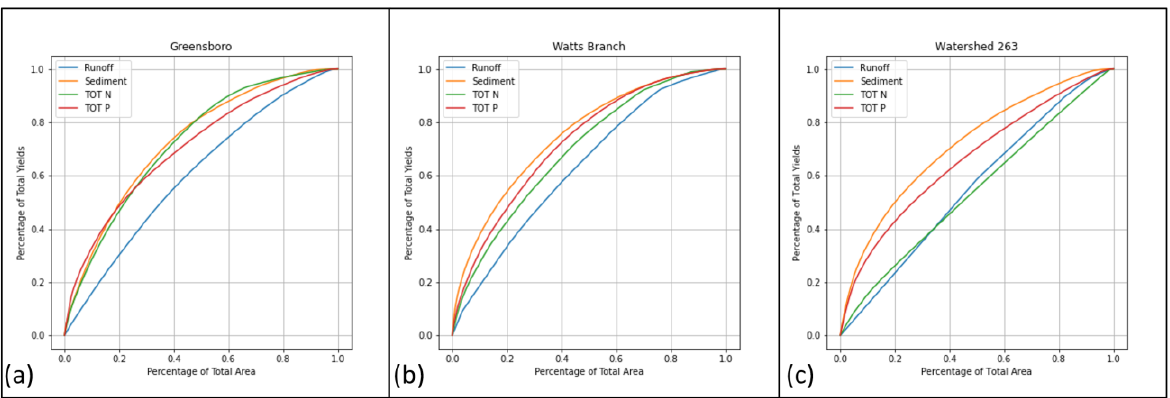
Figure 5. Mass-area ratios of total surface runoff (SurfQ), total sediment (Sed), total nitrogen (Tot N), and total phosphorus (Tot P) in each real watershed: ( a ) Greensboro watershed (agricultural), ( b ) Watts Branch watershed (suburban), ( c ) Watershed 263 (ultra-urban).